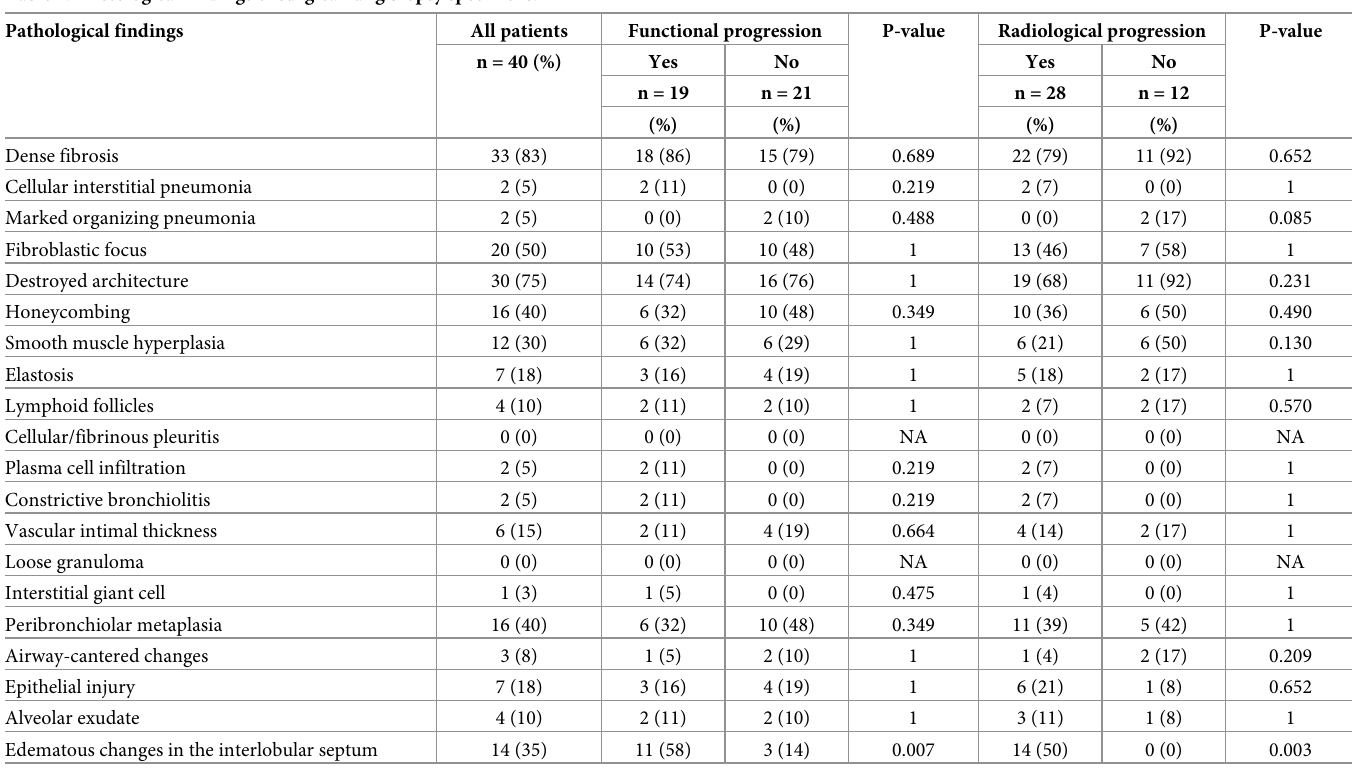
Table 2. Histological findings of surgical lung biopsy specimens.